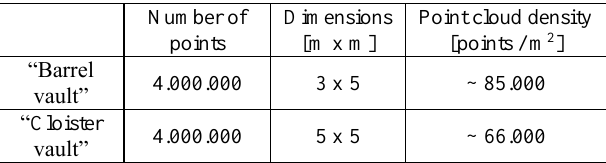
Table 1. Details about the syntactic datasets used in this